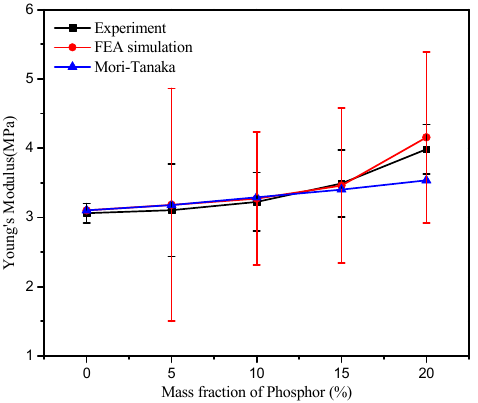
Figure 12. Comparison of transient Young’s modulus results from FEA simulations, Mori–Tanaka calculations and tensile tests.